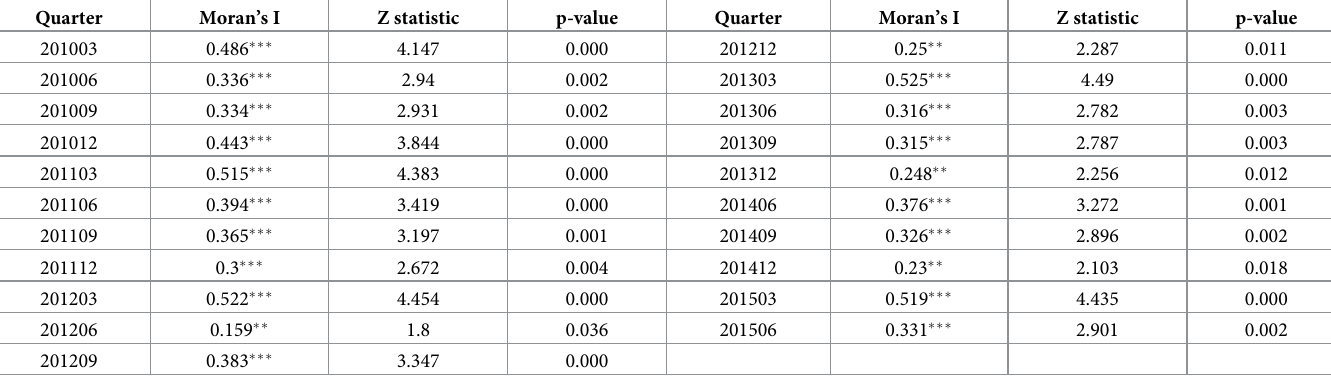
Table 5. Moran’s I of Investment from 2010 to 2015 quarterly.